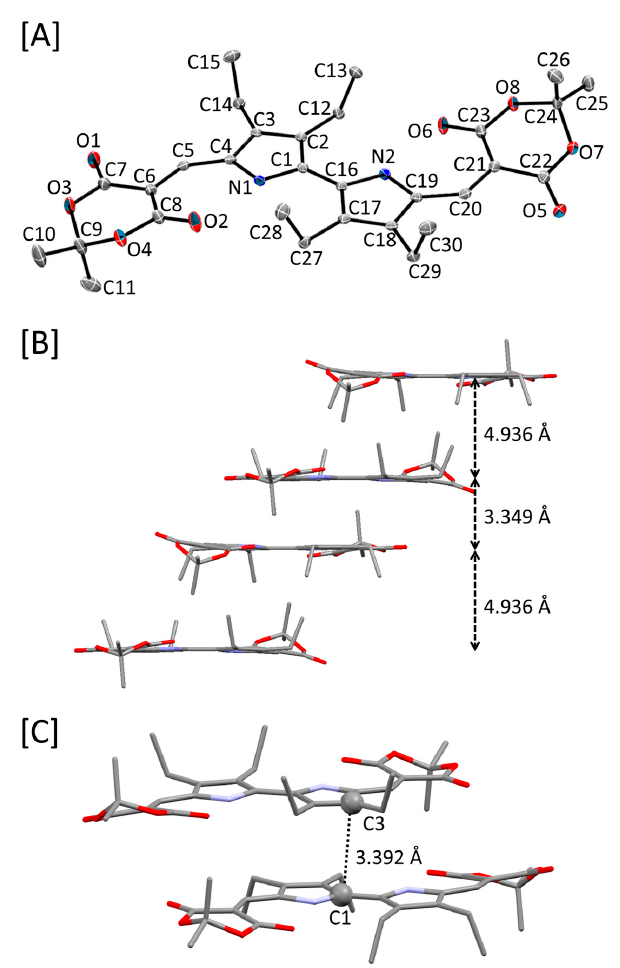
Figure 2. ( A ) The ORTEP diagrams of compound 3 with the atomic labeling; ( B ) Side view with the interlayer distances; ( C ) The closest interatomic distance in a pair of 3 . Hydrogen atoms were omitted for clarity. The thermal ellipsoids were drawn at 50% probability level.